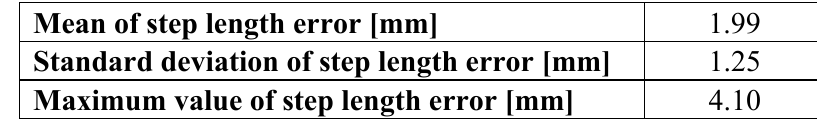
Table 2. Step length estimation error.